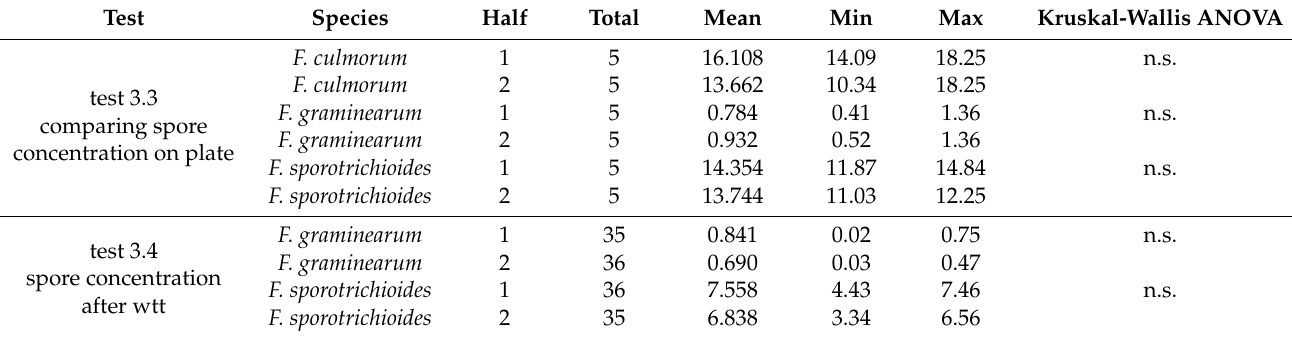
Table 2. Summary of the statistical characteristic values of the tests from Section 3.3 (comparing the spore concentration on Petri Dishes) and Section 3.4 (comparison of spore concentrations before and after wind tunnel treatment). The average values of the respective Fusarium strains divided into their studied halves are shown. Along with the extreme values, the general mean, sample size, and the result of analysis of variance (ANOVA) with Kruskal-Wallis are indicated. Kruskal-Wallis ANOVA was performed at a significance level of 0.05. n.s.: not